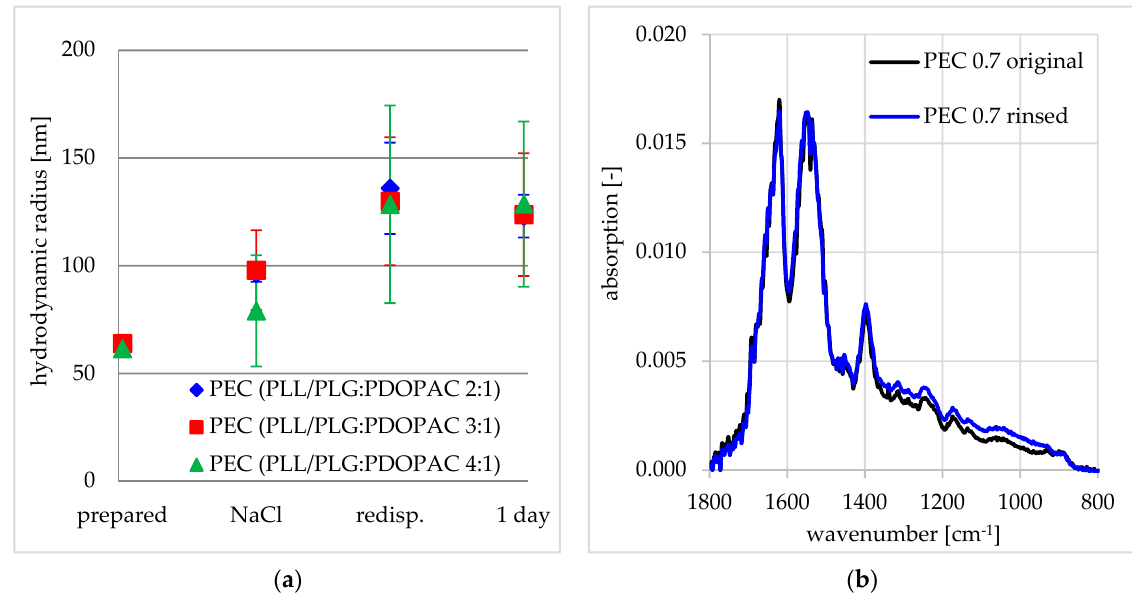
Figure 4. Colloid and adhesive properties of PDOPAC / PEC 0.7. ( a ) Evolution of hydrodynamic radii of the nanoparticles in dispersion measured by dynamic light scattering (DLS) and ( b ) transmission IR spectra of PEC coatings before and after rinsing.